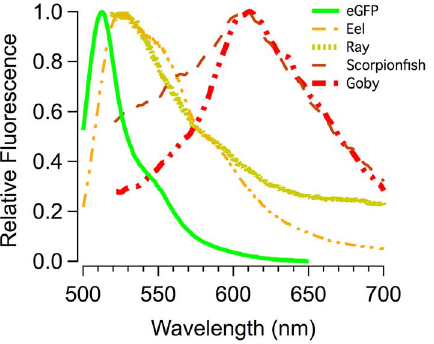
Figure S1 Maximum likelihood topology of the evolutionary relationships of ray-finned fishes inferred from the analysis of 221 species (representing more than 145 families), with six gene fragments (one mitochondrial, five nuclear). Table S1 Biofluorescent fishes known to date. Taxa are listed alphabetically by Order (column 1), Family (column 2), and